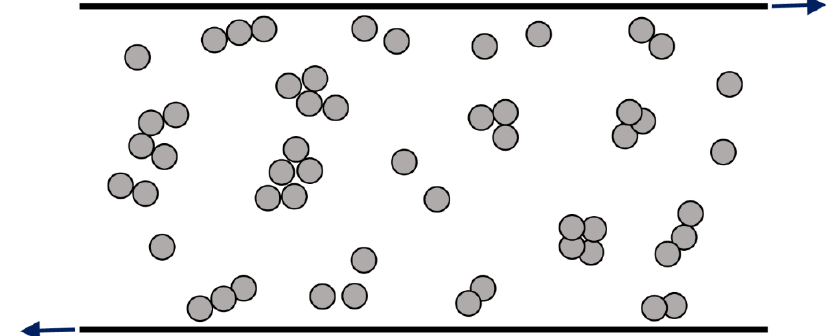
Figure 1. Aggregation/clustering in shear flow of suspension of non-Brownian hard spheres.